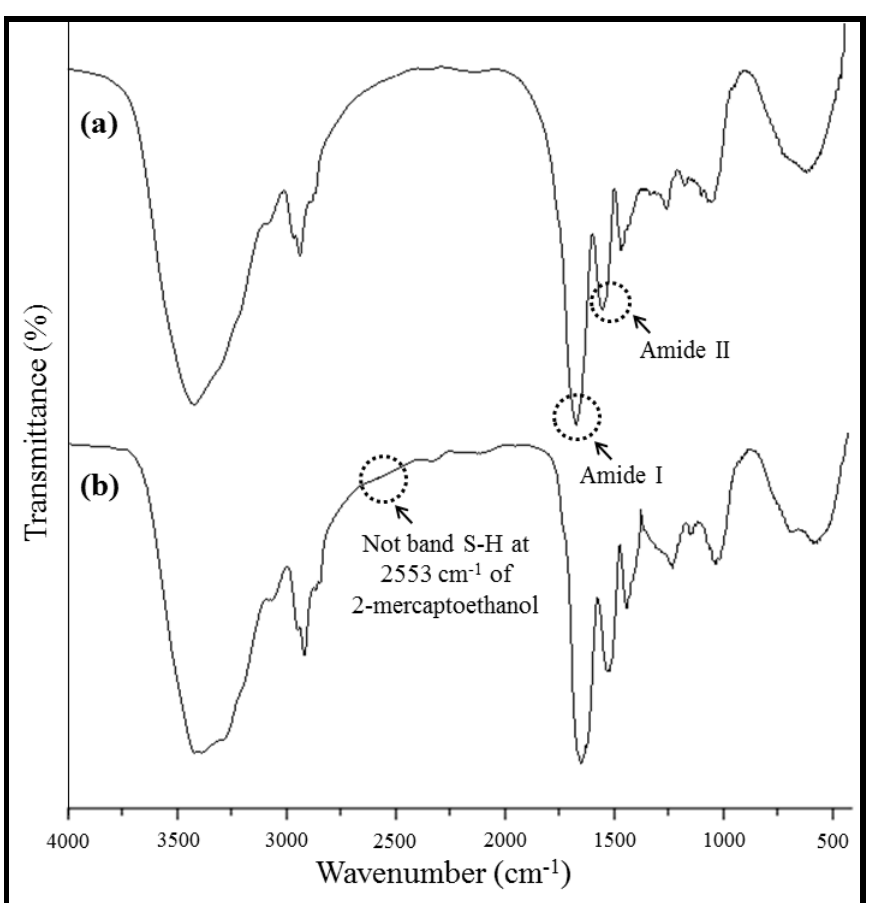
Figure 2. Fourier transform-infrared spectroscopy (FT-IR) of ( a ) WG powder and ( b ) WG membranes obtained by